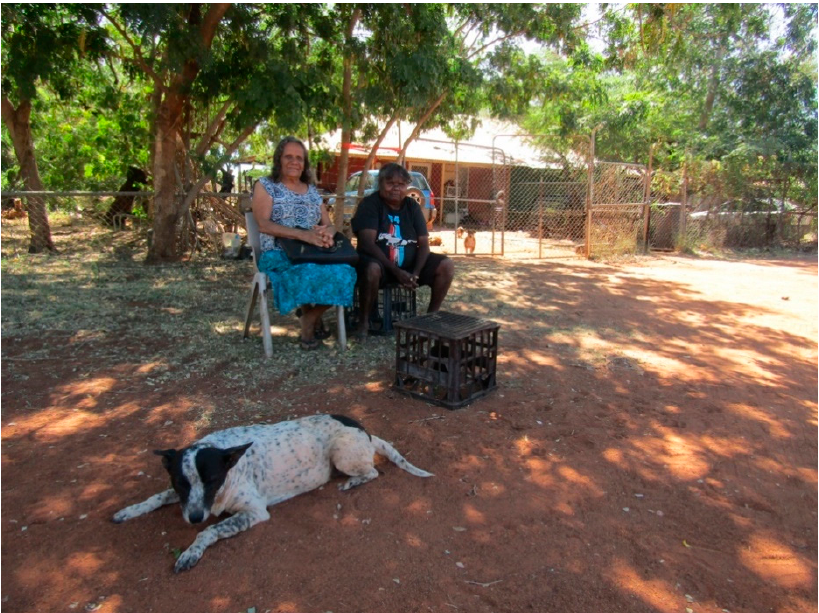
Figure 8. Biddy Morris and Carlene Wise, co-authors of Singing Out: Aboriginal Women’s Stories from the Northwest Kimberley, in Western Australia, with Miwa in the foreground. Photograph by James Pillsbury.